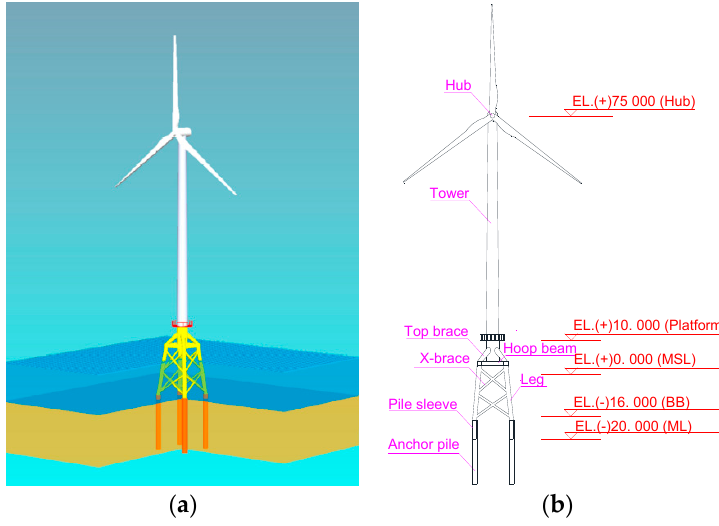
Figure 2. A sketch map of the jacket substructure: ( a ) three-dimensional view; ( b )